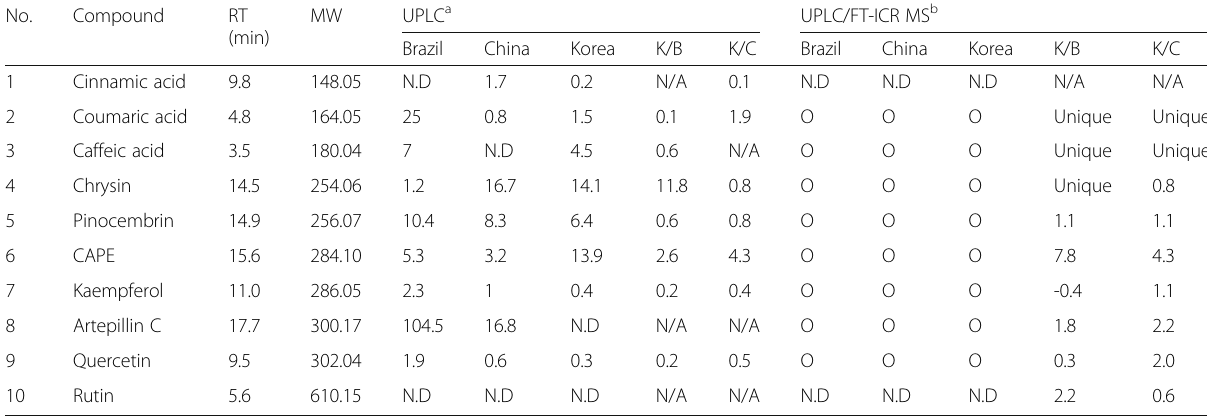
Table 1 Comparisons of ten phenolic compounds identified from EEP samples using UPLC and UPLC/FT-ICR MS No. Compound RT MW UPLC a (min)